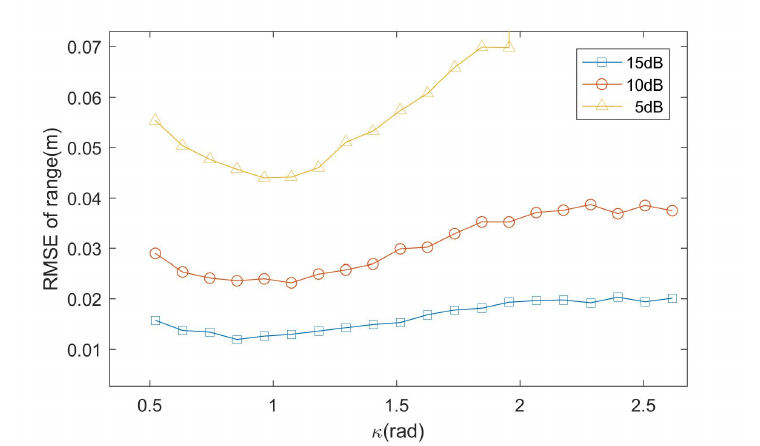
Figure 3. Variation in the ranging RMSE with the modulation depths at different SNRs.